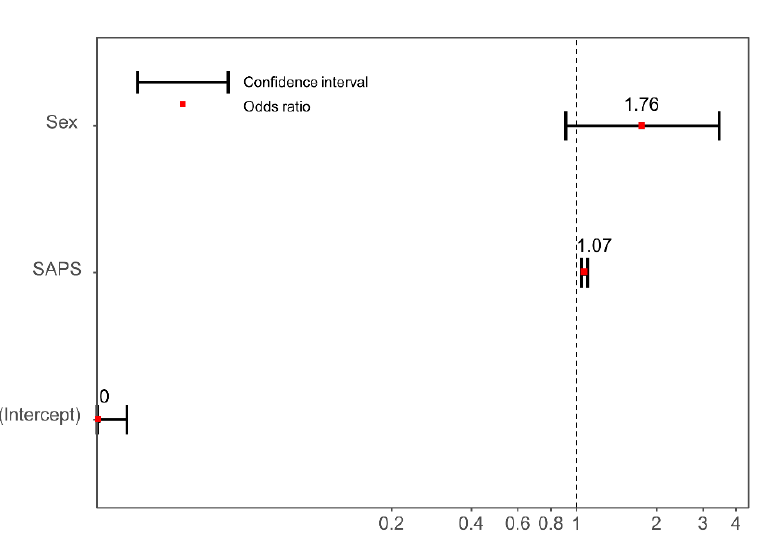
Figure 3. Independent predictors of in-hospital mortality for septic shock patients. Sex, age, time from onset of initial symptoms to ED arrival, time from arrival to administration of antibiotics, the SAPS III, and the pre-COVID-19 and post-COVID-19-onset periods were adjusted. The final model included the following potential risk factors: sex and the SAPS III. Error bars indicate 95% confidence interval and red dots indicates odds ratio. Acronyms: COVID-19, coronavirus disease; and SAPS, Simplified Acute Physiology Score III.